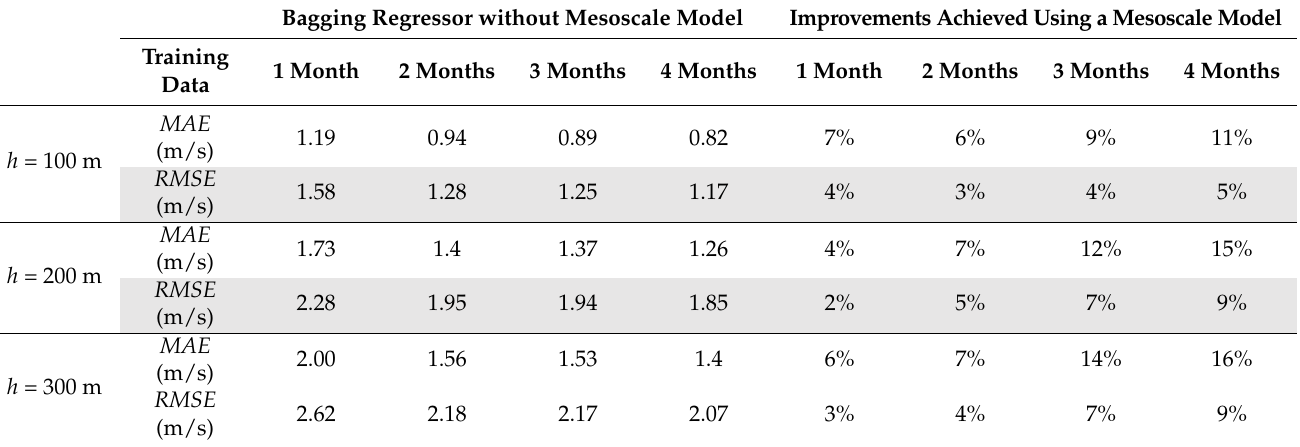
Table 6. Quantification of the impact of the mesoscale model on the bagging regressor results. Bagging Regressor without Mesoscale